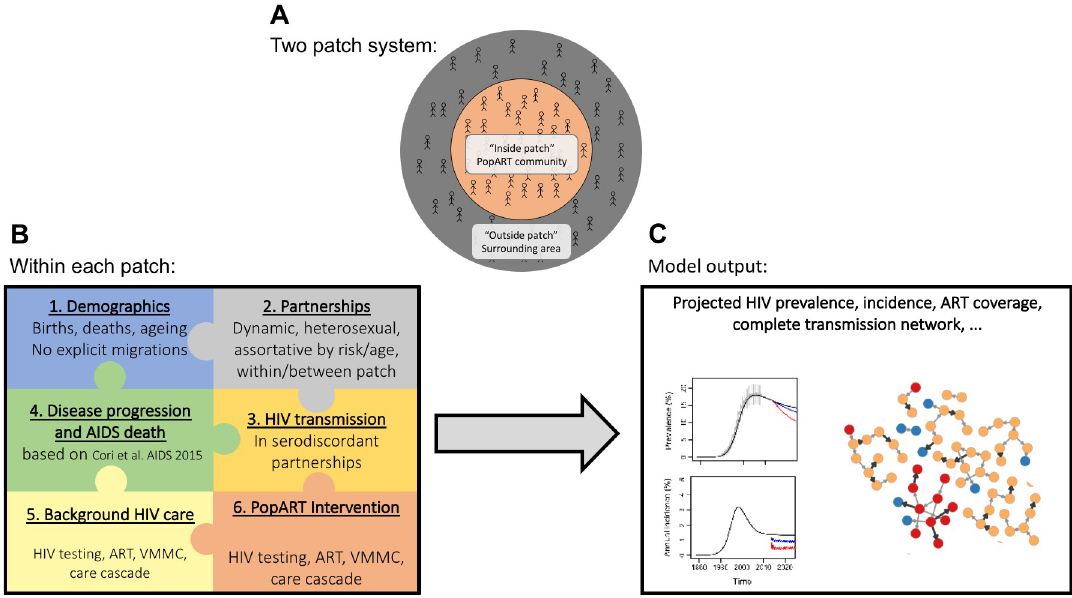
Fig 1. Overview of the structure of the codebase of the PopART-IBM model. A) a metapopulation structure for modelling the PopART community (inside patch) and a surrounding area (outside patch); B) within each patch the codebase is partitioned into several processes related to demographics, sexual partnerships, HIV transmission and disease progression, and interventions; C) the nature of the model being individual-based allows detailed output from the model including the complete HIV transmission network.